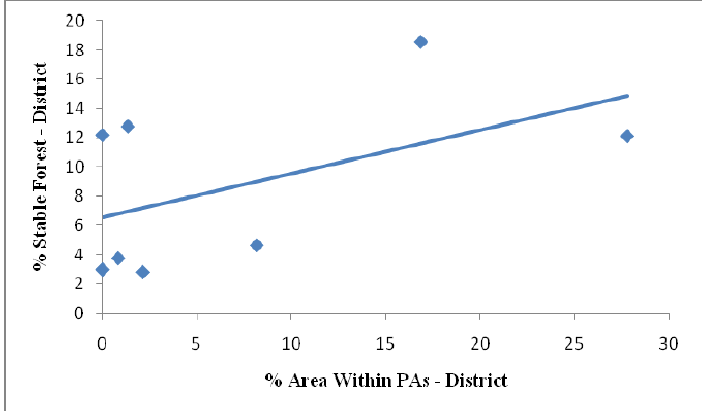
Figure 14a. Relationship between percentage of area within PAs and the distribution of stable forest for districts.